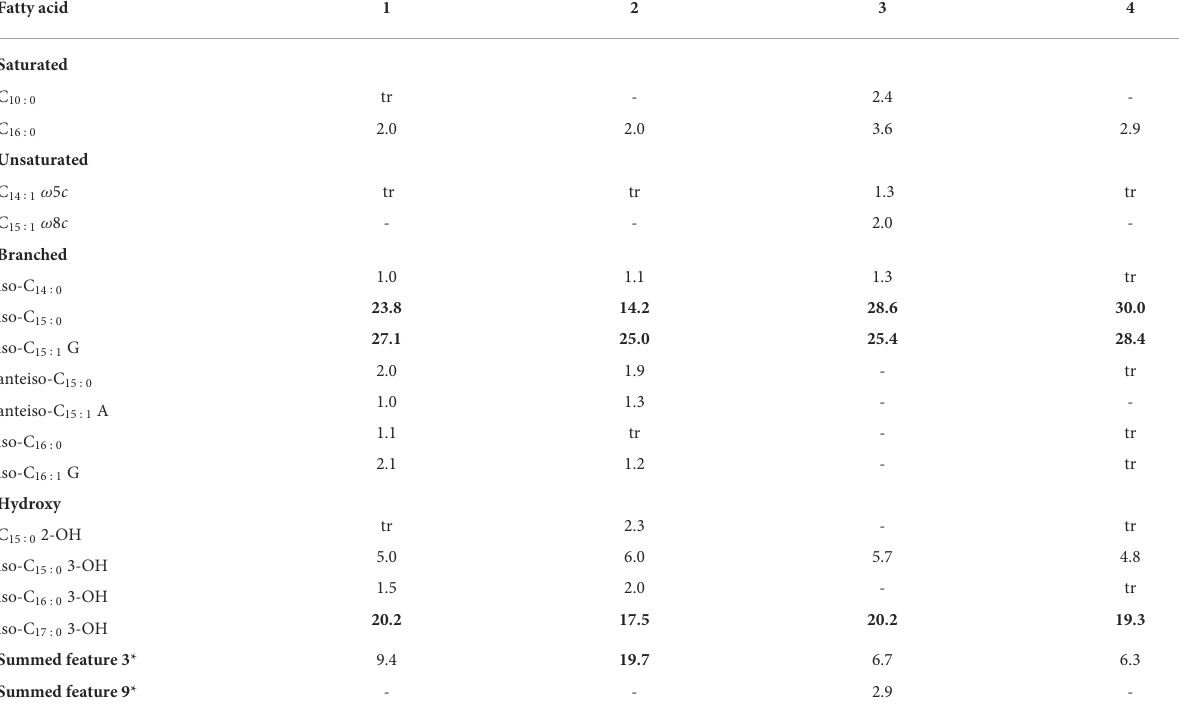
TABLE 2 Cellular fatty acids for strains NBU2968 T , NBU2984 T , and related type strains of the genus Hanstruepera . Fatty acid